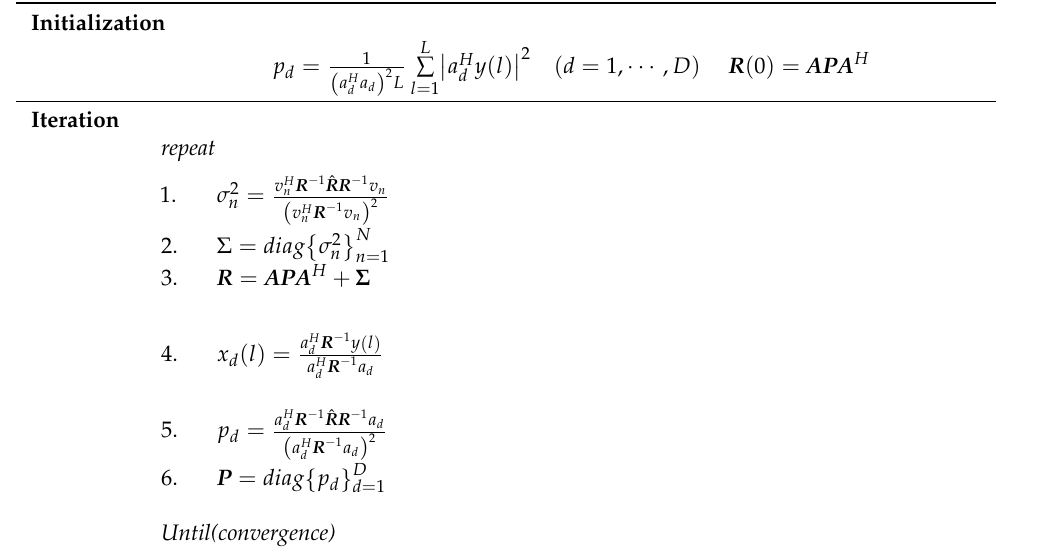
Table 2. Details of the RIAA